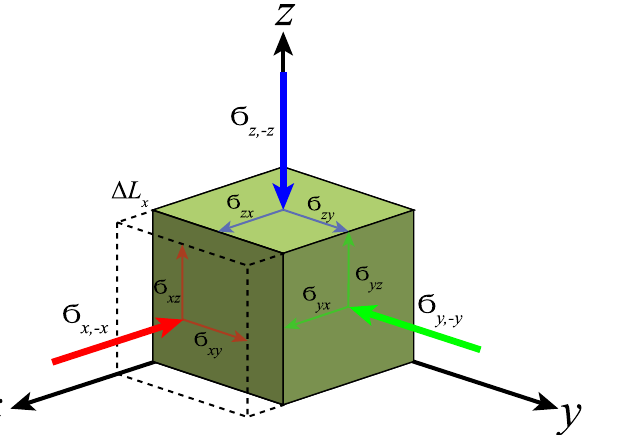
Figure 1. Uniaxial stress application in a solid. Schematic representation of the 9 stress components: 3 normal stresses ( σ x , x , σ y , z ) and 6 shear stresses ( σ xy , σ xz , σ yx , σ yz , σ zx , and σ zy ). All the stress components y , and σ z , − − − can be represented in the Voigt’s abbreviated notation σ ij 20 , as discussed in more details in the main text. The dashed lines indicate the length variation (cid:31) L x when an uniaxial compressive stress σ x , on Ref. 21 . The application of uniaxial stress can be used for the adiabatic magnetization of a paramagnetic salt, cf. depicted in Fig. 2 and discussed in the main